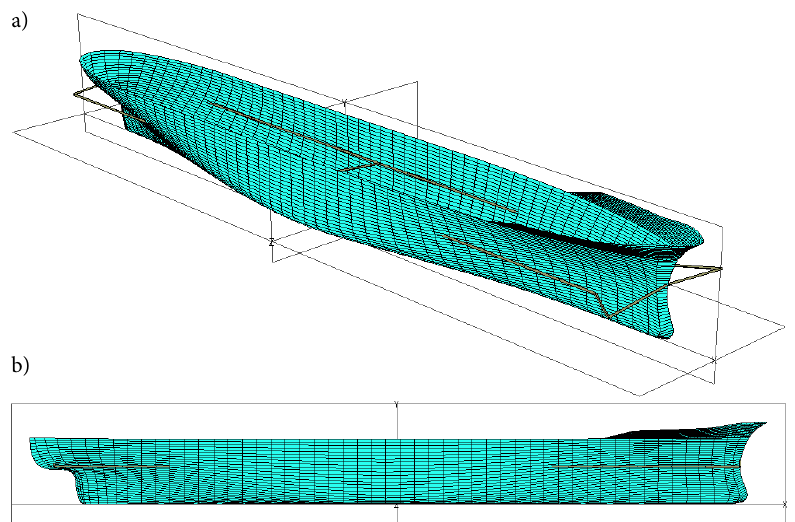
Figure 3. FE model of S-175 container ship: a – 3D model; b – profile view